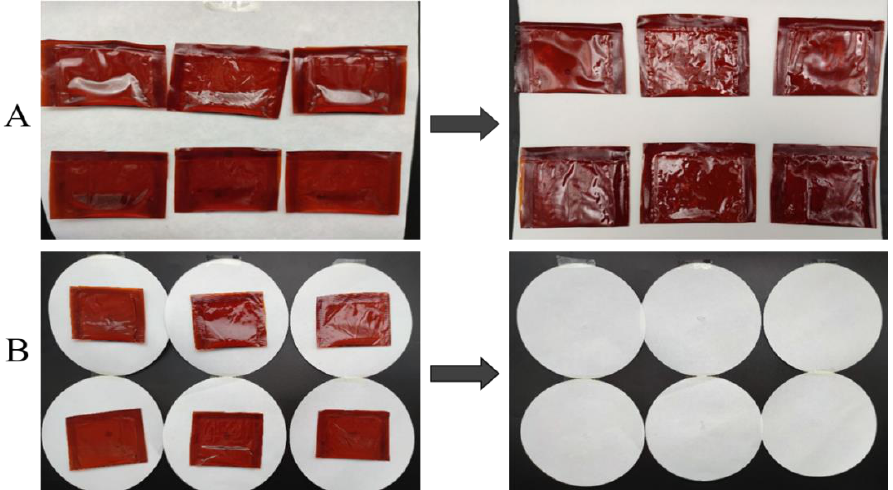
Figure 7. ( A ) is the composite film oil coating before (left) and after (right) throwing. ( B ) is the compressed composite film oil packaging sample (left) and filter paper (right). Table 6. First-order kinetic equation of peroxide value of oil at different storage temperatures.